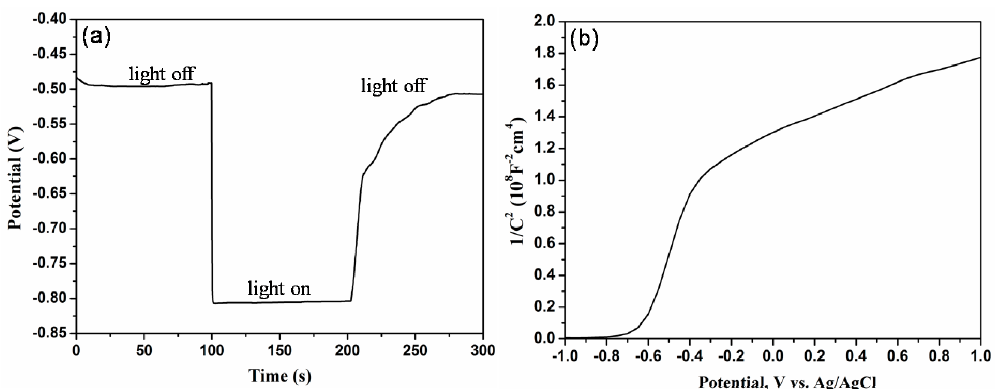
Figure 6. ( a ) Open-circuit potential of Ti-Ni-Si-O nanostructure photoanodes; ( b ) Mott-Schottky plots of Ti-Ni-Si-O nanostructure photoanodes with a frequency of 1000 Hz.